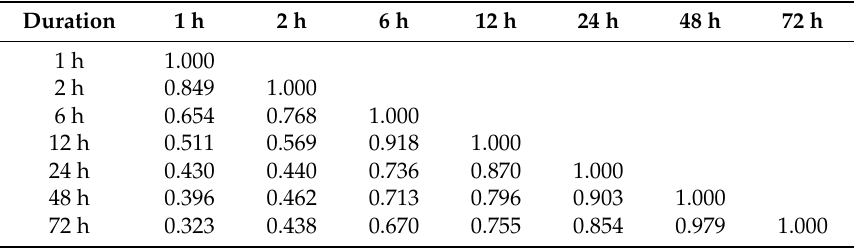
Table 5. Correlation coefficients of normal-transformed rainfall intensity of different durations.